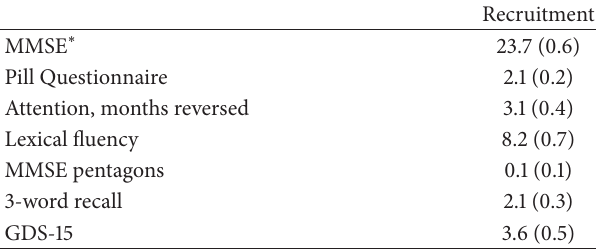
Table 1: Cognitive parameters. Values are mean (SD). NS = not significant. ∗ MMSE corrected for the adjustments according to age and